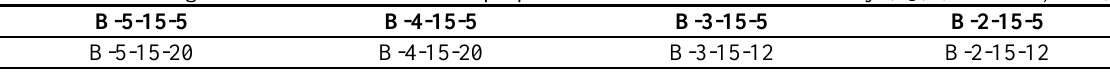
Fig. 18. The accuracy of pushover analysis in estimation of displacement demands for soil types. Table 9. The bridges selected for evaluation of proposed corrective coefficient validity (C